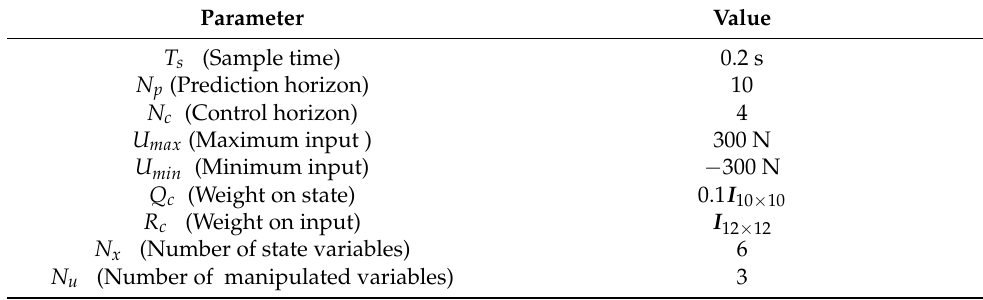
Table 6. The MPC parameters.